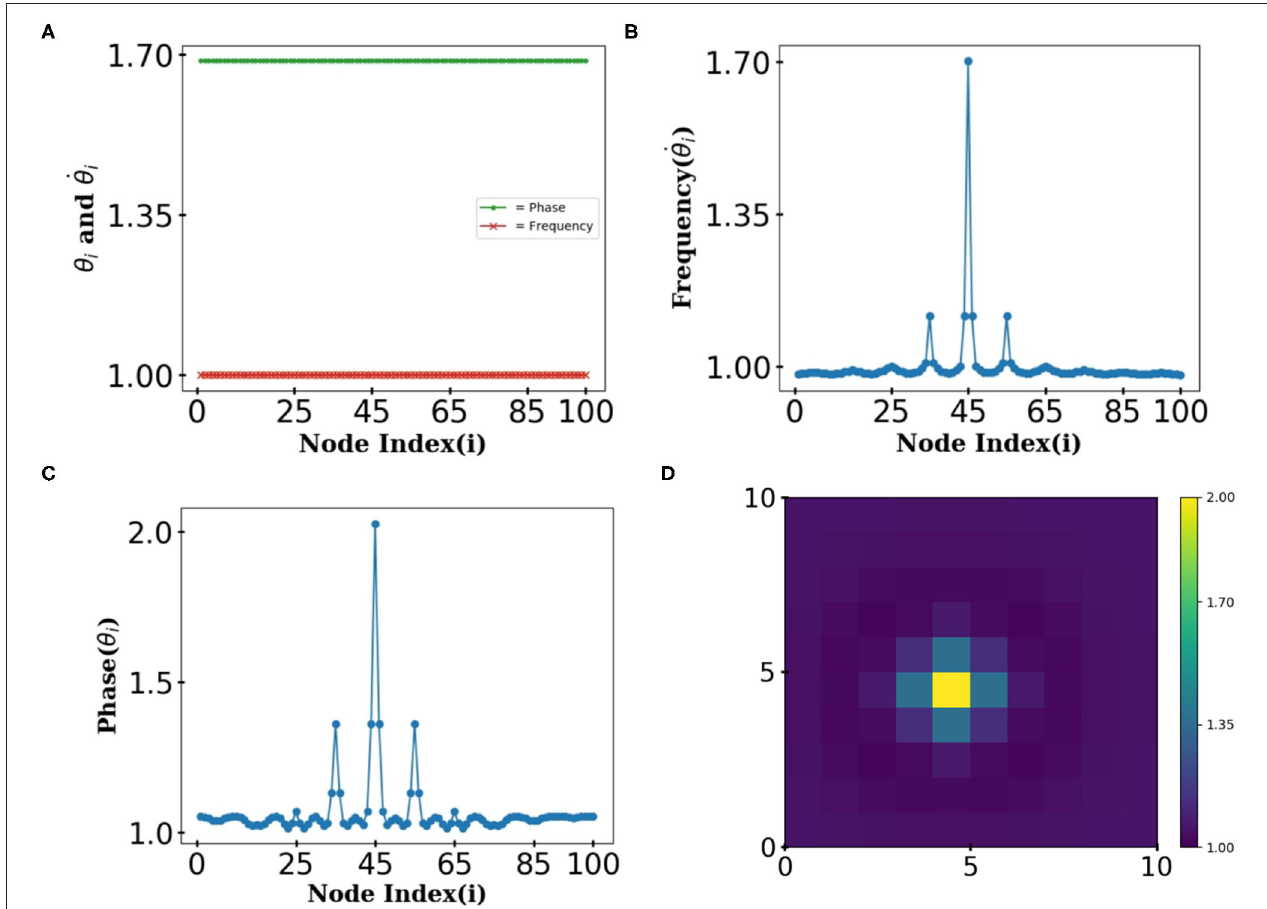
FIGURE 2 | Phase and frequency snapshot of 2-D lattice of N = 100 nodes and µ = 1. (A) Phase and frequency snapshot of the nodes in the absence of delay ( τ = 0). (B) A frequency snapshot and (C) a phase snapshot of the nodes in the presence of delay ( τ = 10) in all the links to 45th node. (D) A heatmap representation of the phases in (C) . (B–D) Demonstrate rippling chimera